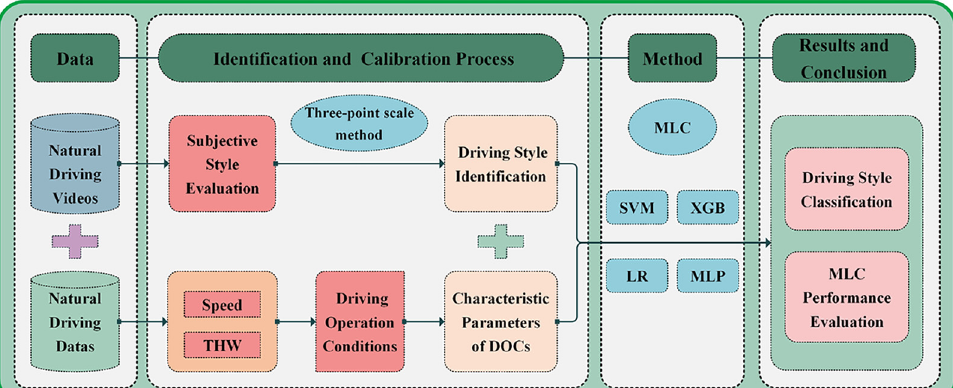
Figure 5 Research strategy of driving style identi fi